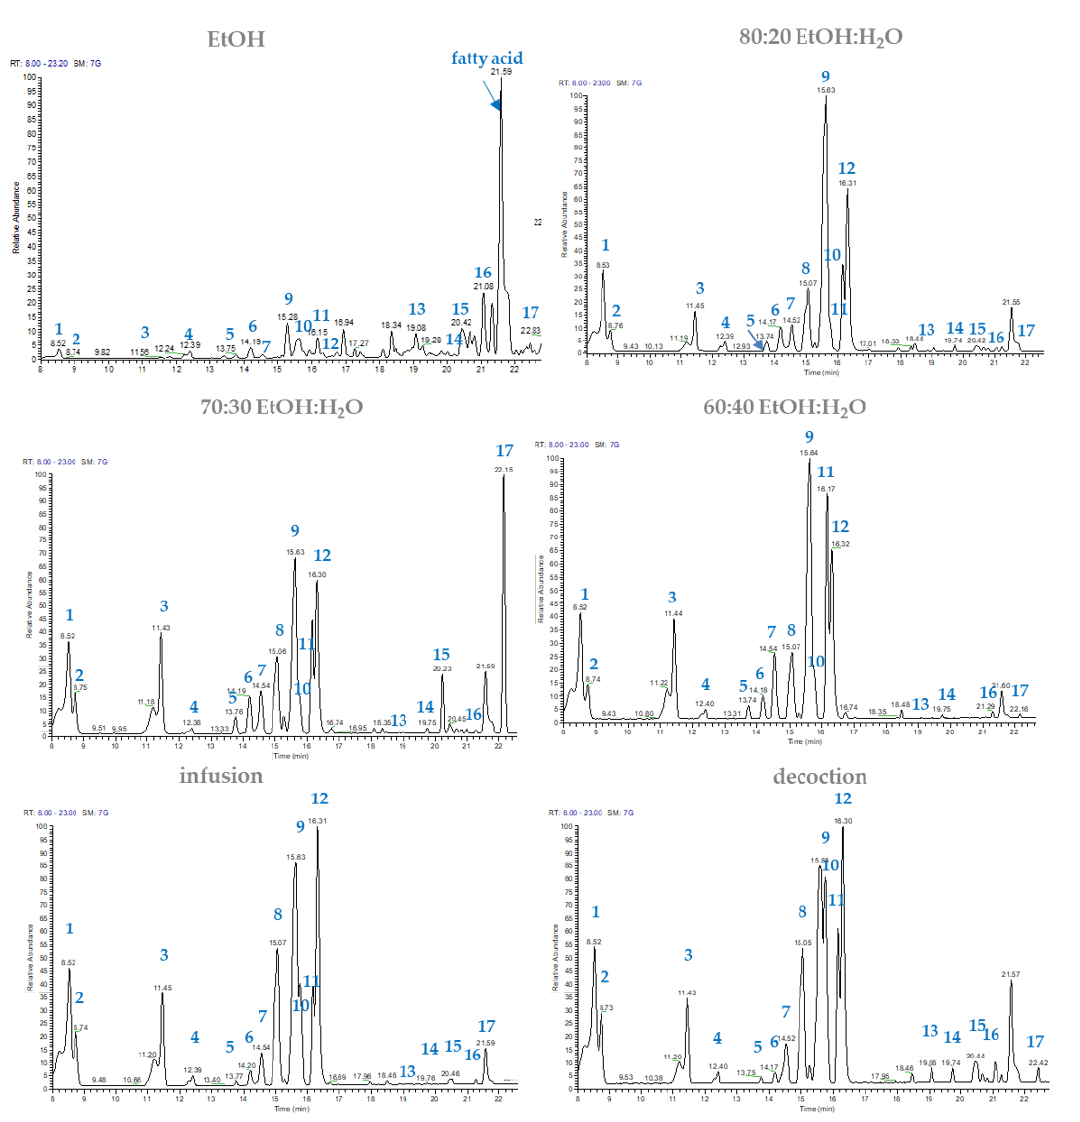
Figure 2. LC-ESI/QExactive/MS profile of different extracts of heads of “Carciofo di Paestum” Figure 2. LC-ESI/Q Exactive/MS profile of different extracts of heads of “Carciofo di Paestum” PGI .